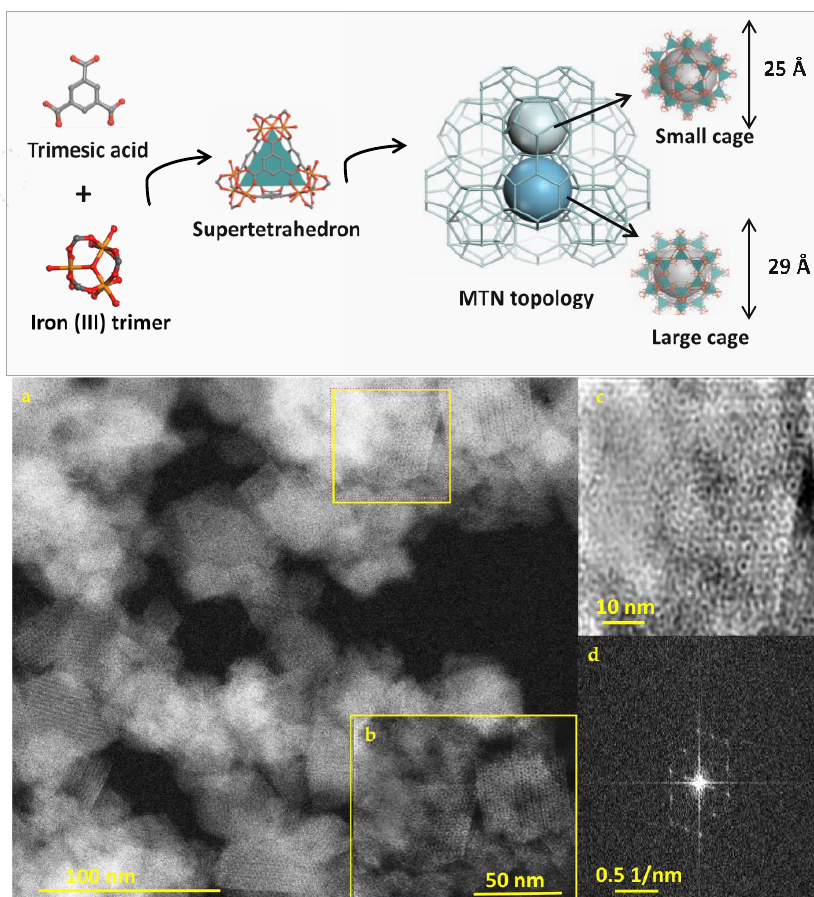
Figure 1. Upper panel: Schematic representation of the structure of MIL-100 (Fe) obtained by the self-assembly of iron supertetrahedra. Two cages 25 and 29 Å (small and large cage) are accessible through microporous pentagonal windows of 5 Å and microporous hexagonal windows of 8.6 Å. The structures were designed using Material Studio. Lower panel: Scanning TEM with High Annular Dark Field Mode (STEM-HAADF) images of MIL-100(Fe) nano Metal-Organic Frameworks (MOFs), ( a ) unprocessed image, ( b ) magnified image, ( c ) inverse FFT filtered STEM-HAADF image, and ( d ) FFT pattern which reveals the crystallinity of the particles. The ultrahigh resolution of STEM-HAADF shows the ordered porous structure of submicron particles.